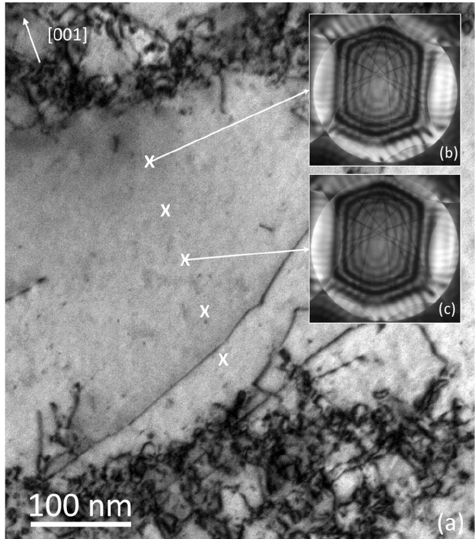
Figure 4. Convergent beam electron diffraction (CBED) patterns were recorded across channels to assess the internal stresses in the direction of applied stress [001]. ( a ) A channel illustrating the locations where the CBED patterns were acquired. ( b ) The <411> CBED pattern that was recorded closer to the wall and ( c ) in the middle of the channel.